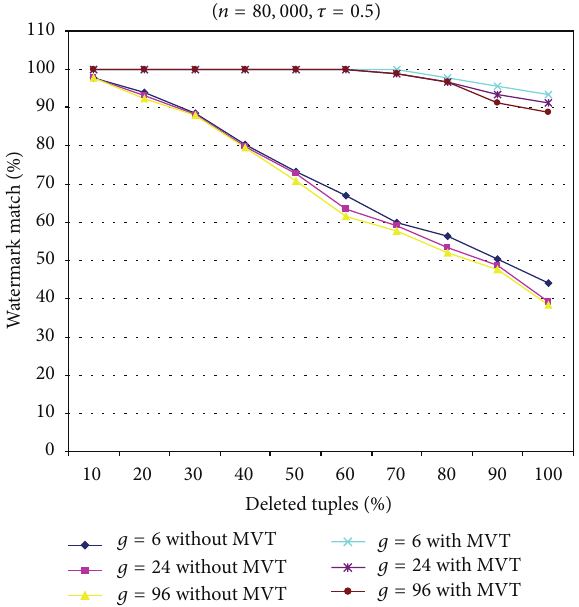
Figure 3: Resilience to alteration attacks with and without MVT for different values of parameter 𝑔 .